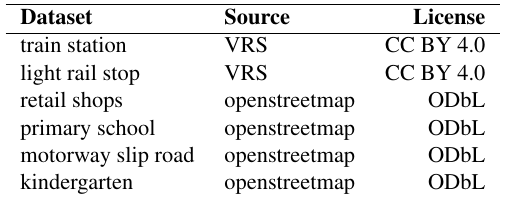
Table 1. Open datasets used for predictors and indicators. For VRS see VRS - Opendata and Open Service -